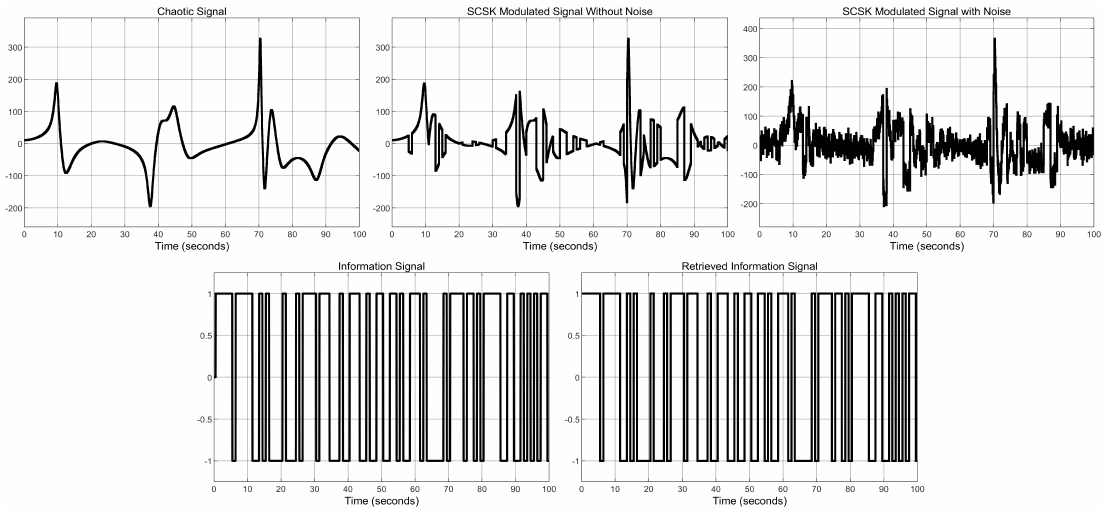
Figure 10. Simulation results of the SCSK secure communications design, for chaotic signal 100 · x .